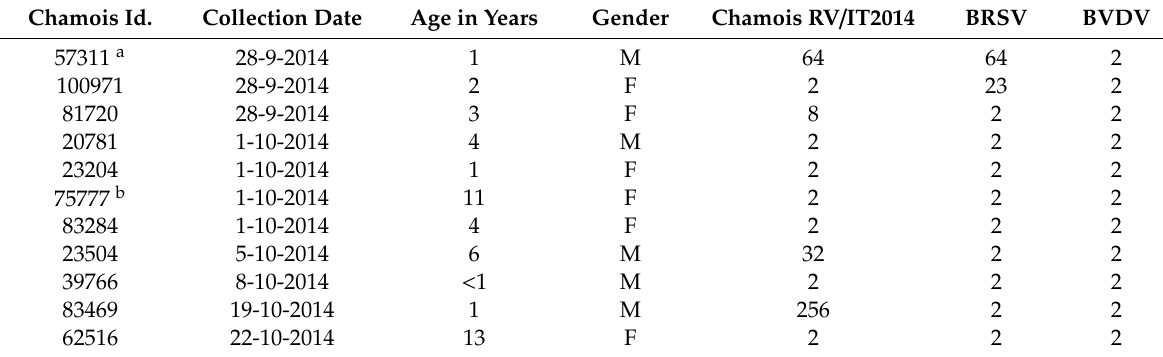
Table 2. Virus neutralization titers of hunted chamois sera against the chamois strain from this study, bovine respiratory syncytial virus and bovine viral diarrhea virus. Chamois